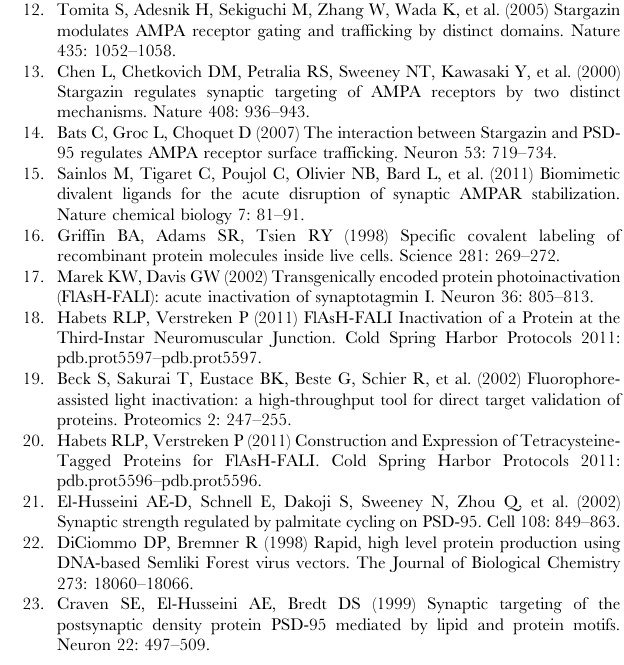
Figure S1 Tetracysteine motif is required for FALI of PSD-95. COS cells expressing RFP-PSD-95-wt and Kv 1.4-CFP show perinuclear clusters highly co-localized as observed in Figure 1. Cells were incubated with FlAsH and illuminated for 2 minutes following protocols as described above. Illumination protocol did not have an effect on the distribution of PSD-95/ Kv1.4